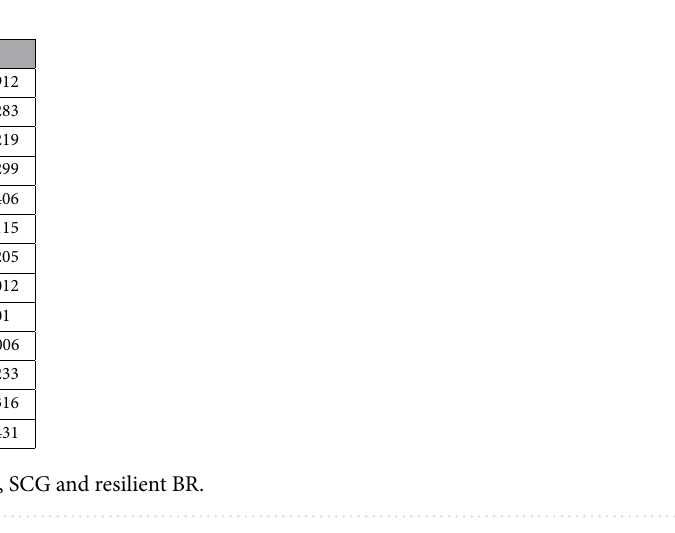
Figure 6. Schematic diagram of the proposed ANN model with hidden layer.